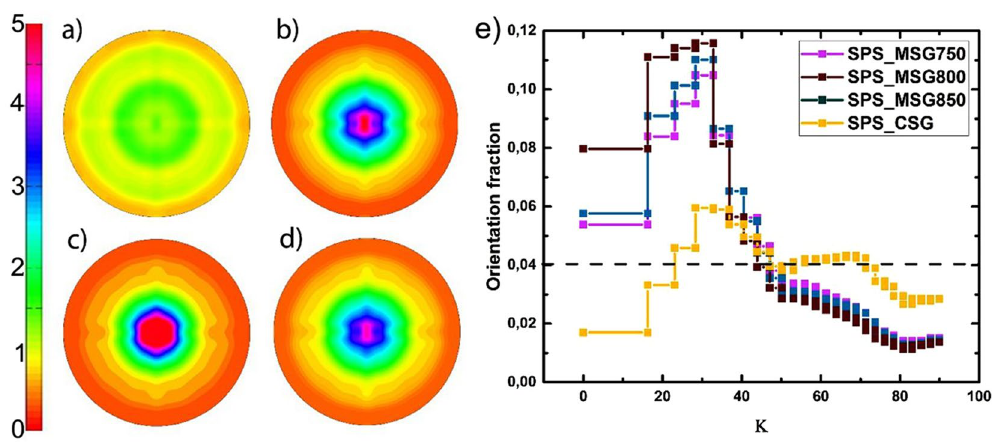
Figure 7. Orientation distribution function (ODF) of (00 l ) poles obtained from X-ray PF measurements of ( a ) SPS_CSG and ( b ) SPS_MSG850, ( c ) SPS_MSG800, ( d ) SPS_MSG750, ( e ) Oriented volume fraction of SPS_ MSG750, SPS_MSG800, SPS_MSG850, and SPS_CSG with increasing Κ angle, obtained from the extracted